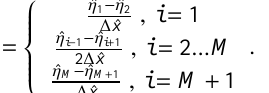
Fig. 1: a central finite-di ff erence scheme is used to solve Eqs. (28) and (29).